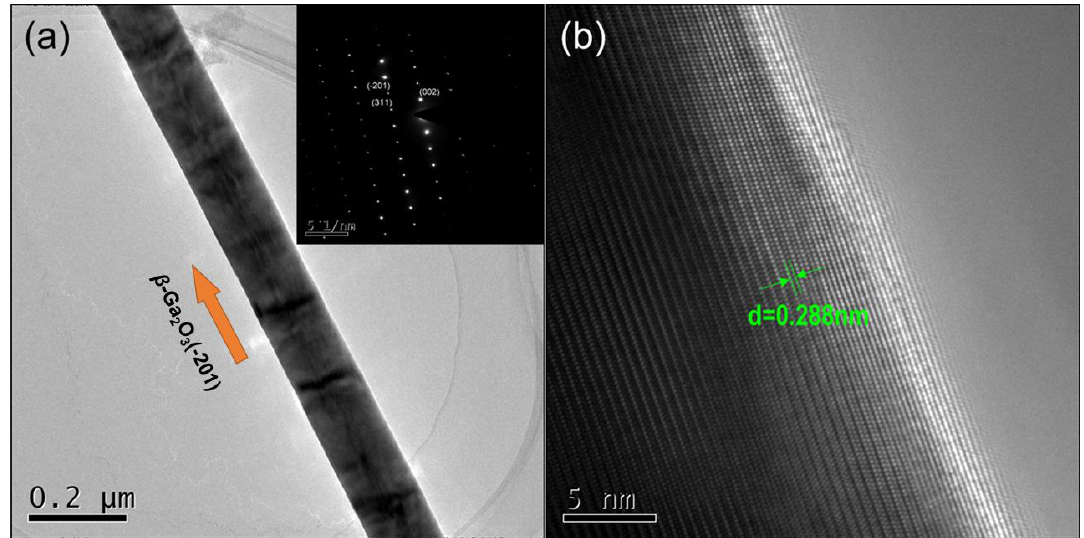
Figure 5. ( a ) Transmission electron microscopy (TEM) image of an individual β -Ga 2 O 3 nanowire. The typical electron diffraction pattern is in the inset. ( b ) High-resolution TEM image of the β -Ga 2 O 3 nanowires with uniform lattice fringes.